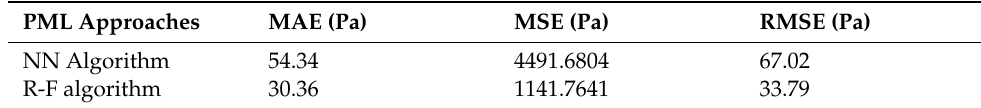
Table 2. Statistical outcomes of yield stress for employed models.